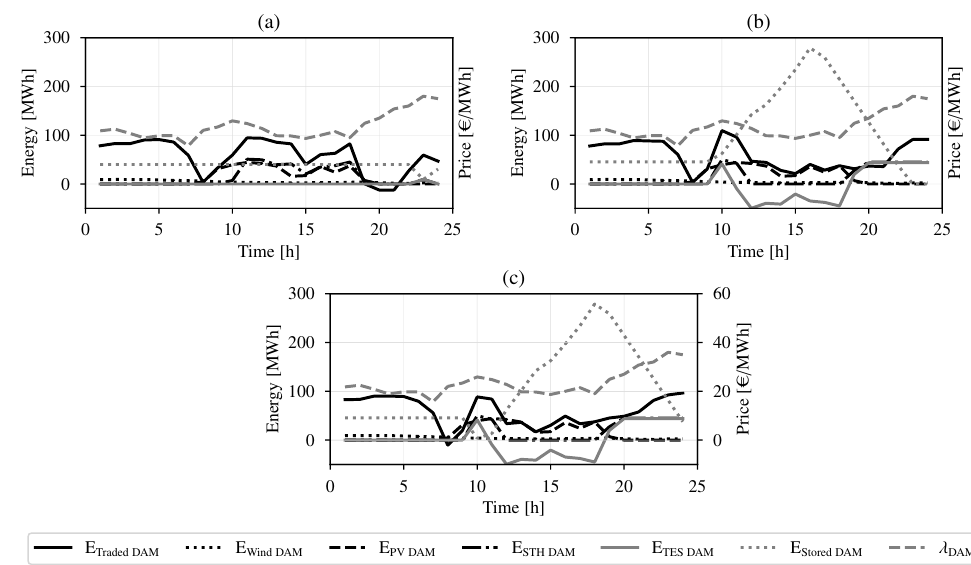
Figure 11. Output of assets at DAM on a cloudy day: ( a ) No Coordination; ( b ) VPP with default load profile; ( c ) VPP with three load profiles at zero